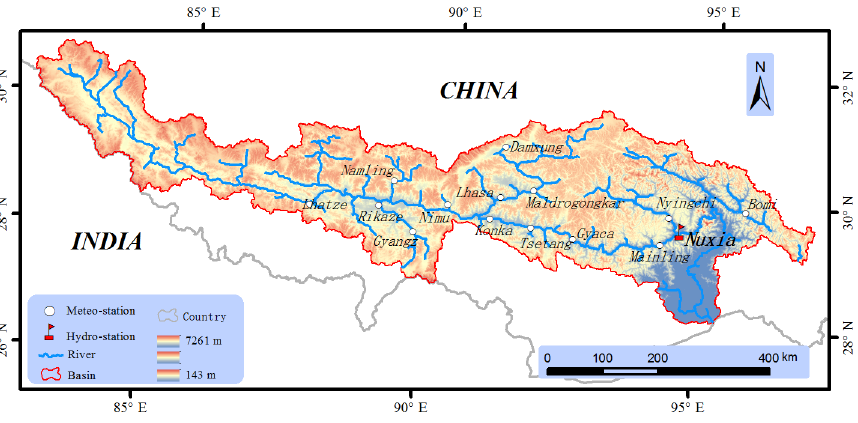
Fig 1. Meteorological and hydrological stations and river network in the Yarlung Zangbo River